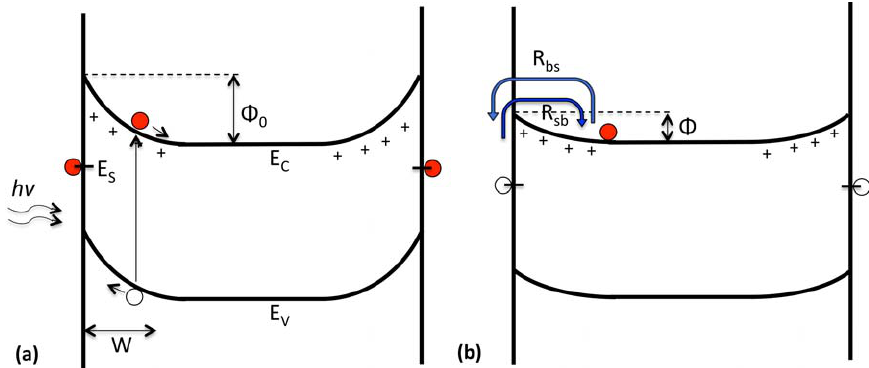
) and from the surface to the bulk ( R ) is regulated bs sb + E − E , 0 C S